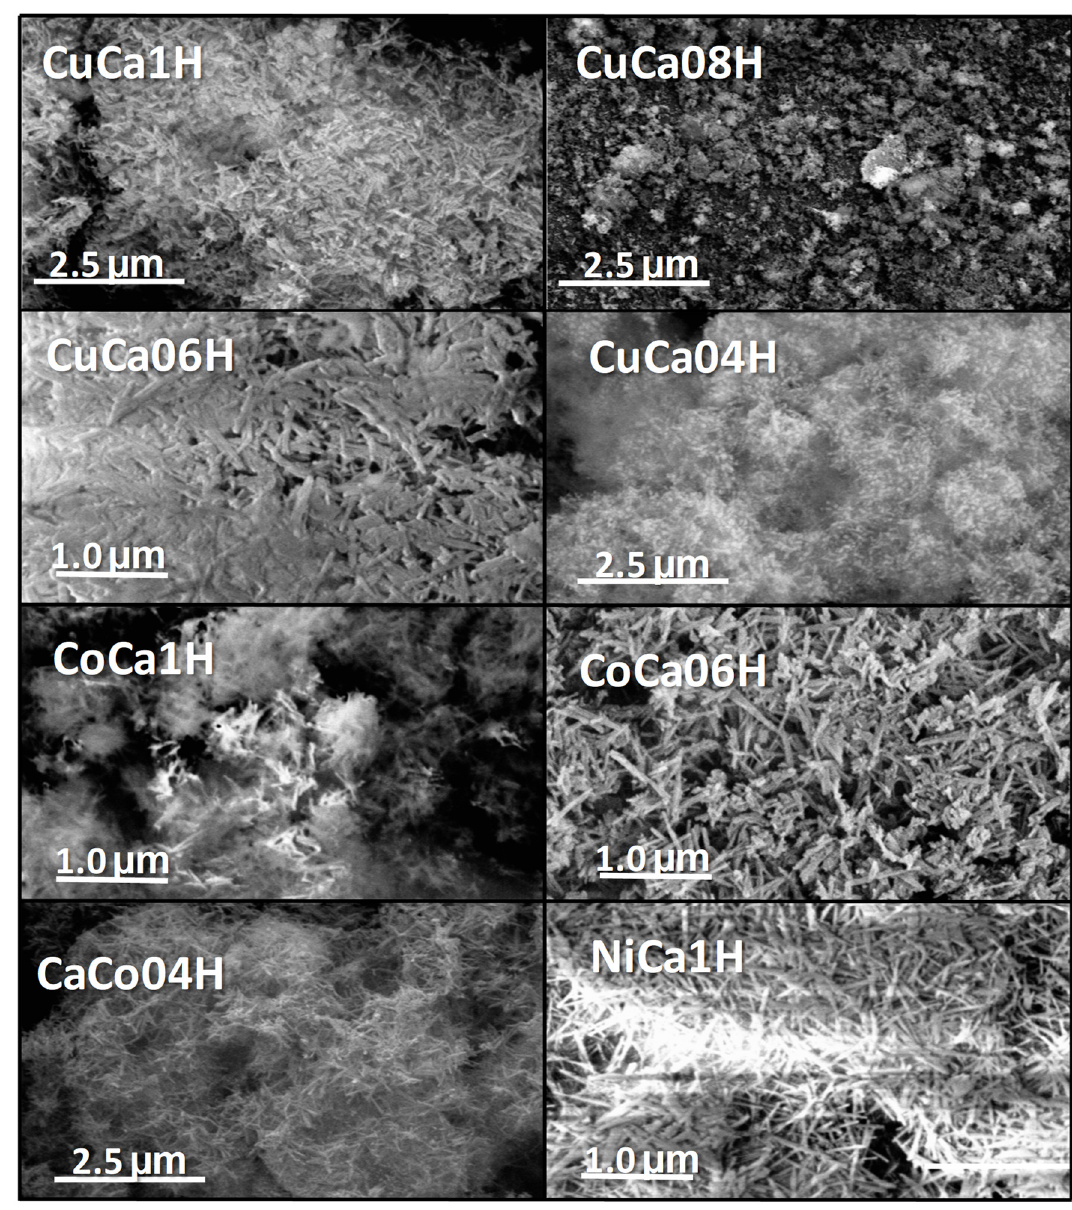
Figure 8. SEM micrographs of the spent solids. The solids are evaluated in the EG reaction at 80 °C and glycerol to acetic acid molar ratio of 0.25. Table 2. Atomic percentages of the elements obtained from EDS spectra. The solids are evaluated